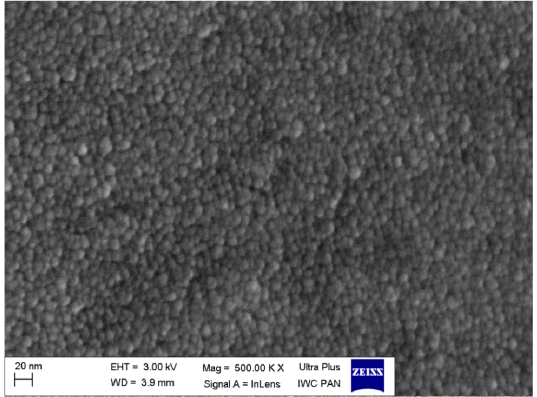
Figure 16. SEM image of a glass-ceramic Bi 2 O 3 sample (at room temperature) obtained by a melt- quenching, followed by heating up to 630 ◦ C. Microstructure consists mostly of 10–20 nm crystallites with the δ -Bi 2 O 3 structure, as evidenced by XRD patterns (T.K. Pietrzak, unpublished